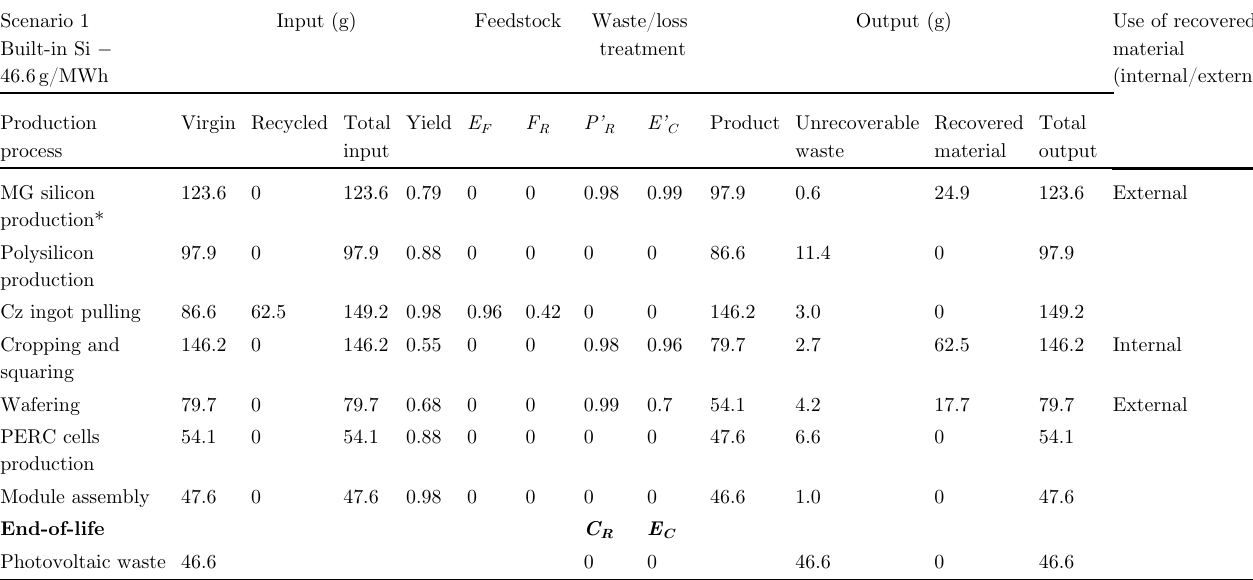
Photovoltaic waste